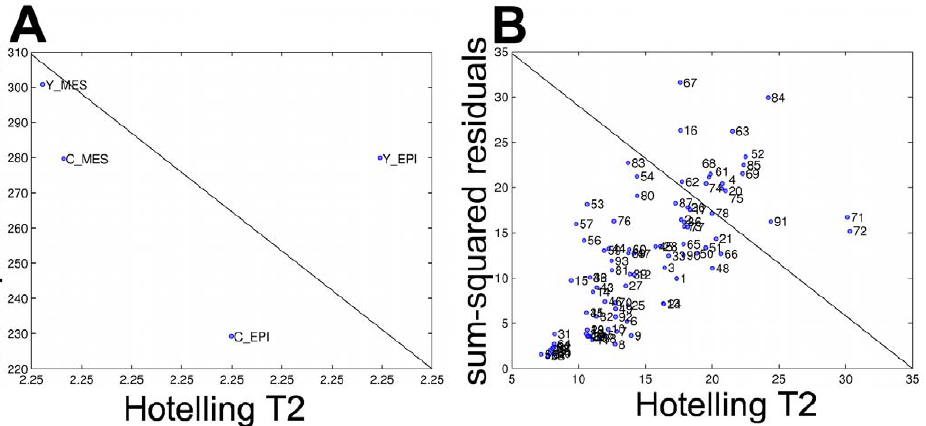
Figure 8. Multiway modeling by tensor analysis. Our dataset is modeled as a higher order array to capture the multilinear structures. (a) Tissue type analysis reveals that the untreated epithelial, untreated mesenchymal and treated mesenchymal tissues are grouped together. (b) Hotelling’s T2 versus sum squared residuals to reveals features that the tensor analysis cannot fit with the model.